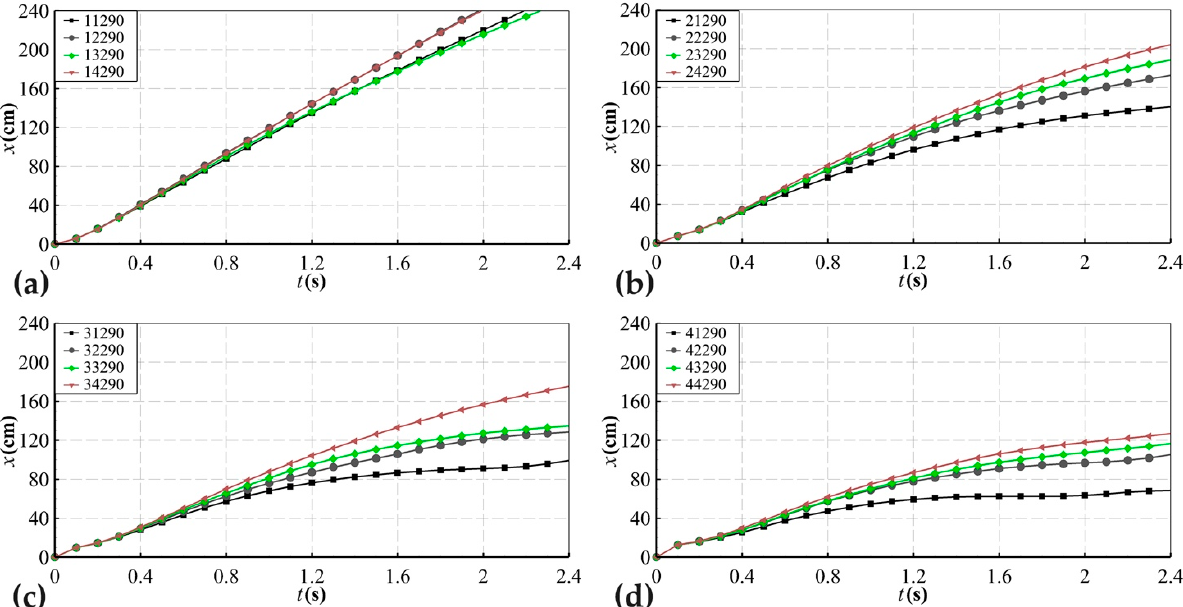
Figure 13. Location of the entire container group after starting the drift at a 0.4 s interval. Configu- rations ( a ) 11190; ( b ) 12190; ( c ) 13190; ( d ) 14190; ( e ) 41190; ( f ) 42190; ( g ) 43190; and ( h ) 44190.